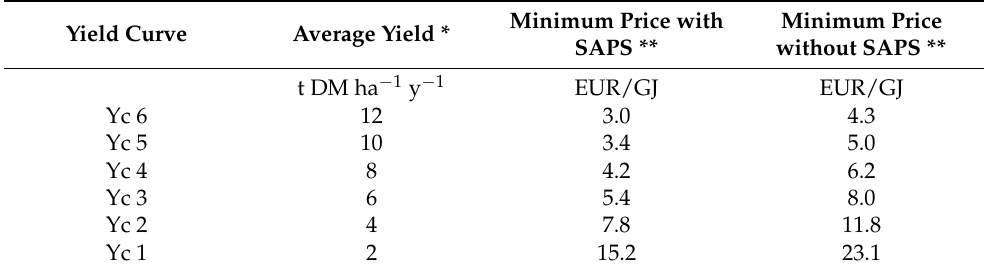
Table legend: * average yield is the average of expected yields during 10 (winter) harvests after establishment; ** the economic model was calculated in Czech Crowns (CZK), and the results recalculated to EUROs using the exchange rate of 1 EUR = 25